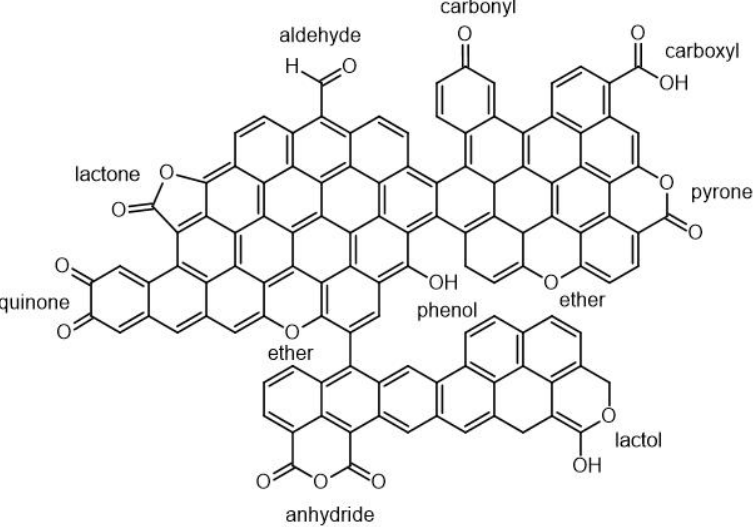
Figure 10. Oxygen-enriched biochar produced by the application of an air steam in mild temperature conditions.